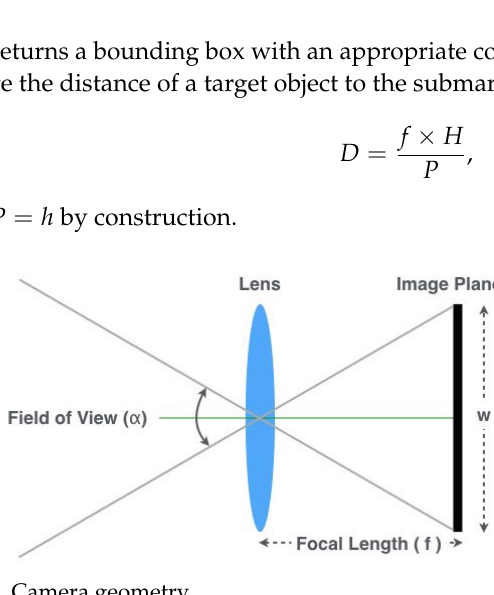
Figure 8. Camera